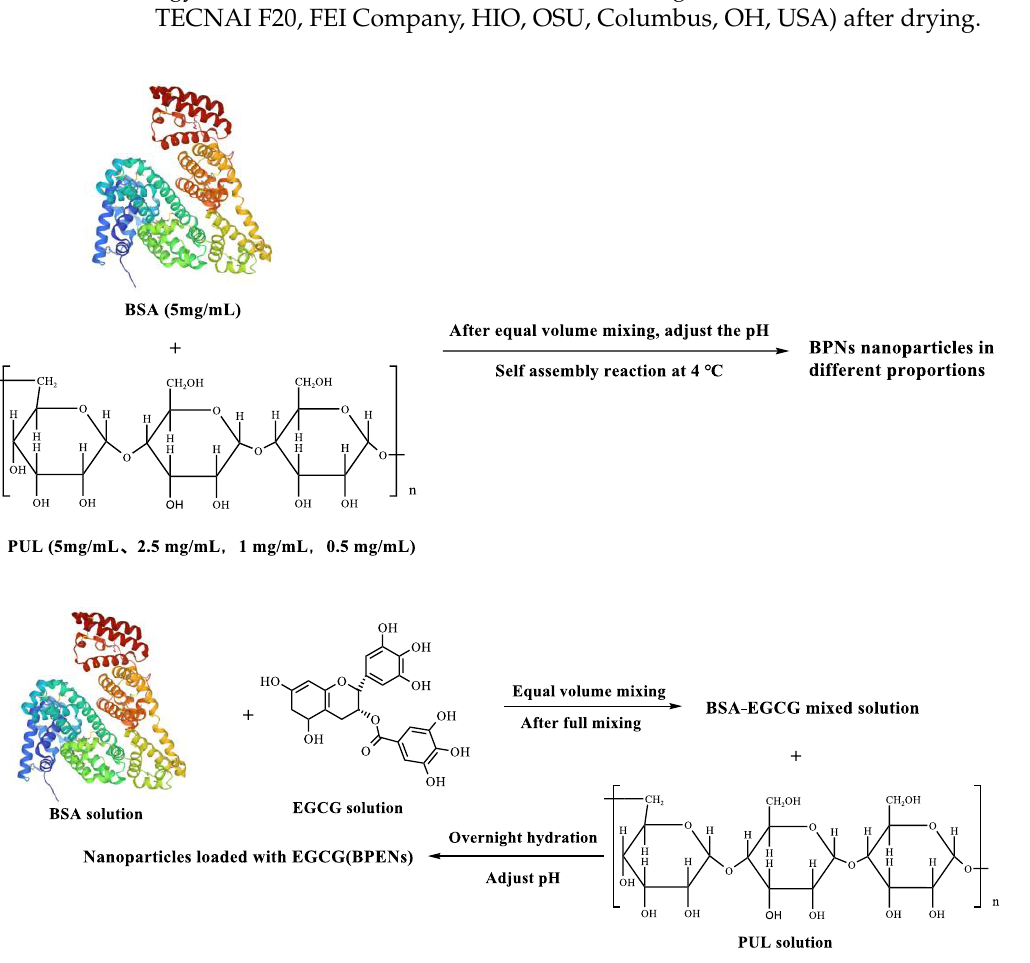
Figure 1. The preparation process of BPNs ( 1 ) and BPENs ( 2